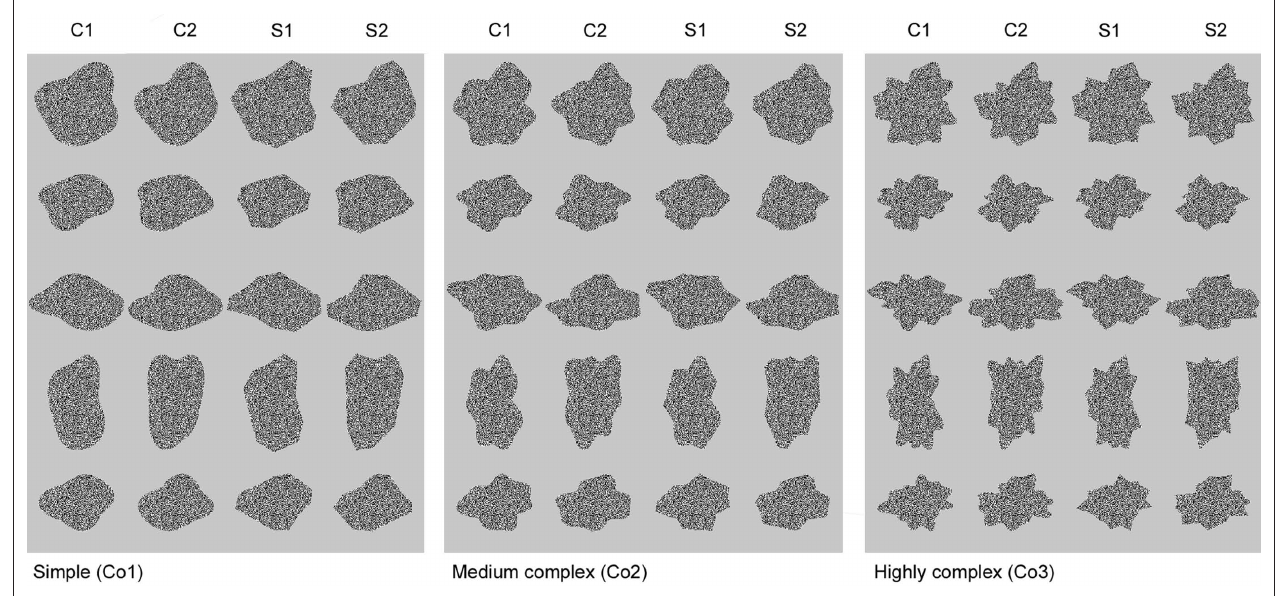
by replacing the curves of the shapes in respectively C1 and C2 with straight lines. Within each series, we measured the sensitivity of IT neurons to changes in the phase of the FBDs by computing the difference in response to the shapes in column C1 and S1 compared to the shapes in column C2 and S2, respectively. And we measured the sensitivity of IT neurons to the presence versus absence of curvature by computing the difference in response to the shapes in column C1 and C2 compared to the shapes in column S1 and